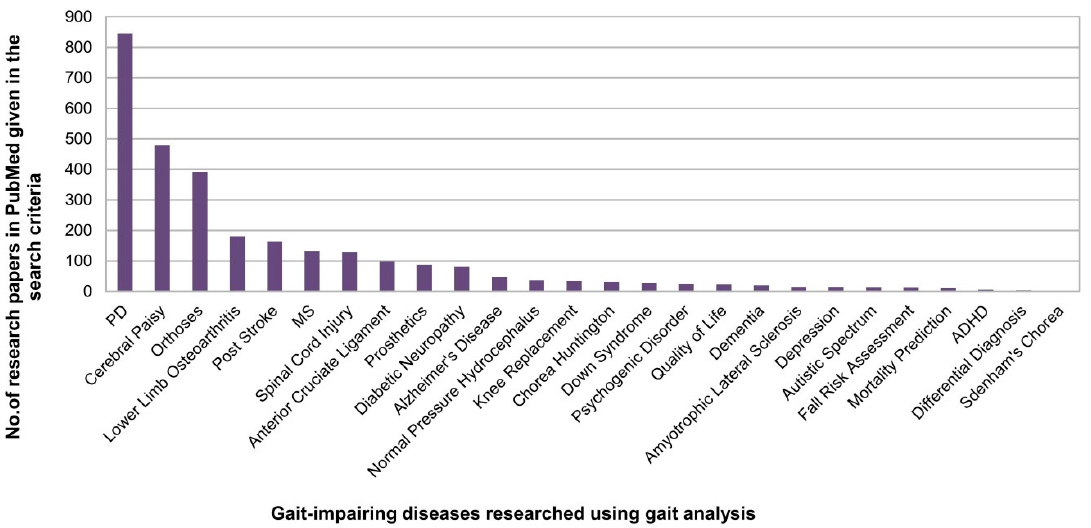
Figure 6. Distribution of research efforts on different gait pathologies (data originates from research papers published between 1970 and 2016). Figure modified with permission of the authors of [25]. PD: Parkinson’s disease; MS: multiple sclerosis; ADHD: attention deficit hyperactivity